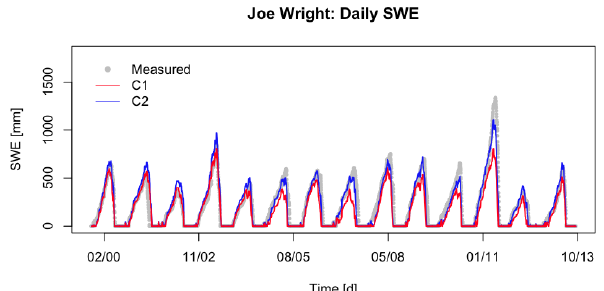
Fig. 5. Calibration and evaluation model results for the station- Figure 5. Calibration and evaluation model results for station- specific calibration test in Joe Wright: the gray dots represent the specific calibration test at the Joe Wright station: the gray dots rep- measured SWE, the solid red line represents the model C1 (classi- caltemperature-indexmodel)andthebluesolidlinerepresentsthe resent the measured SWE, the solid red line represents the model modelC2(CazorziandDallaFontana). C1 (classical temperature index model) and the blue solid line rep- resents the model C2 (Cazorzi and Dalla Fontana).